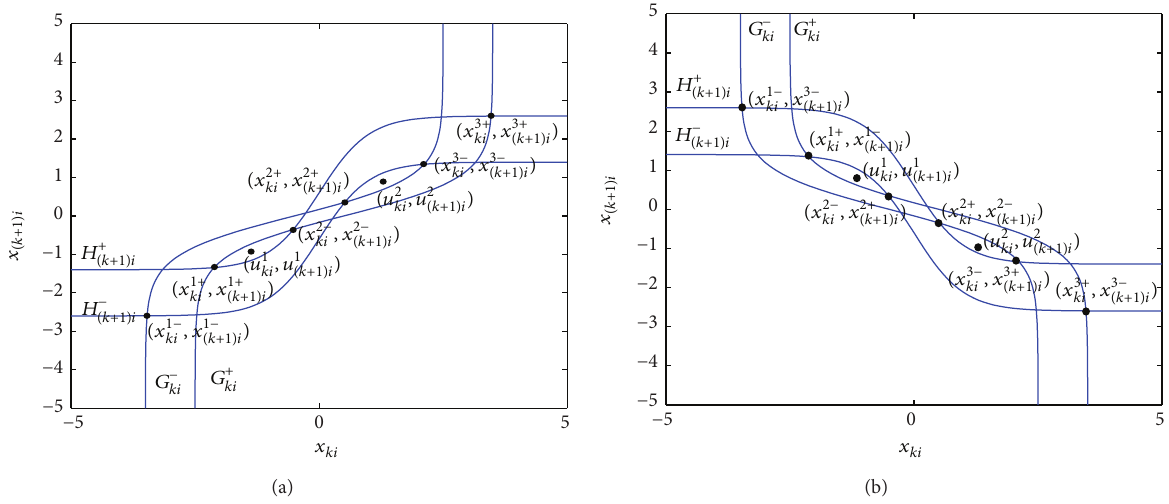
Figure 1: The configurations of 𝐺 + 𝑘𝑖 (𝑦) , 𝐺 − 𝑘𝑖 (𝑦) and 𝐻 − (𝑘+1)𝑖 (𝑥) , 𝐻 + (𝑘+1)𝑖 (𝑥) . (a) 𝑤 𝑘𝑖(𝑘+1)𝑖 ,𝑤 (𝑘+1)𝑖𝑘𝑖 > 0 . (b) 𝑤 𝑘𝑖(𝑘+1)𝑖 , 𝑤 (𝑘+1)𝑖𝑘𝑖 < 0 .